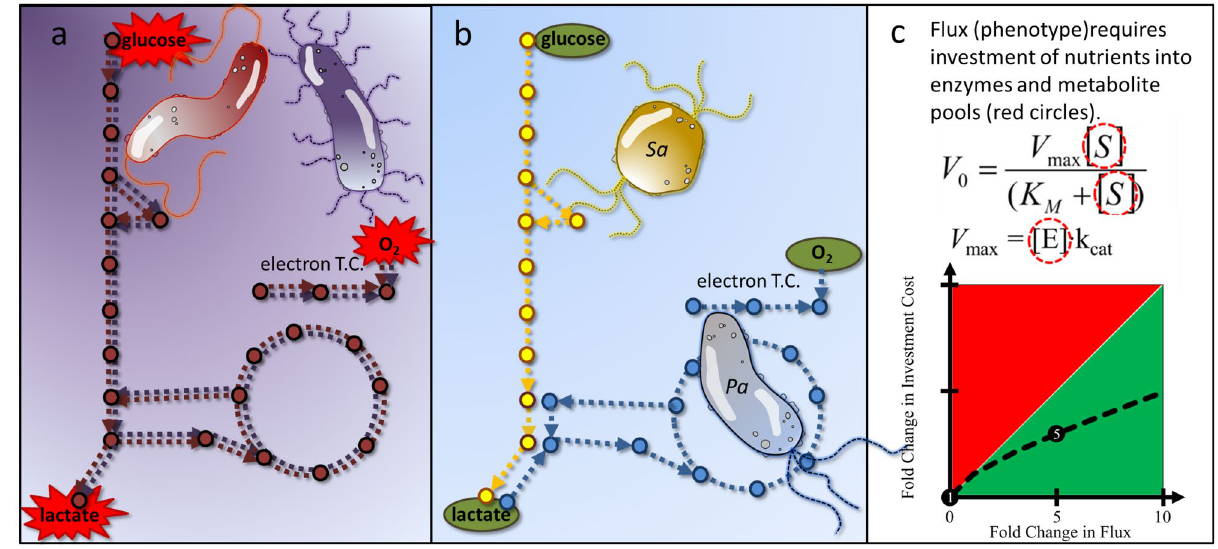
Figure 7. Theoretical consortial interactions including competition and cross feeding. ( a ) Consortium with multiple populations competing for the same electron donor and same electron acceptor and both populations utilizing an overflow metabolism producing inhibitor lactic acid. ( b ) Consortium of rCCR utilizing P. aeruginosa (Pa) and cCCR utilizing S. aureus (Sa) where substrate preferences are partitioned between the two populations and lactic acid is cross fed. ( c ) Cross feeding can lead to enhanced phenotypic properties, such as flux, for a scarce nutrient pool like reduced carbon or nitrogen. Michaelis–Menten-like kinetics and the requirement to invest resources into both enzyme and metabolite pools leads to a nonlinear relationship between invested resources and enzyme flux. Higher fluxes require a smaller, relative resource investment. See Beck et al . 67 for parameter